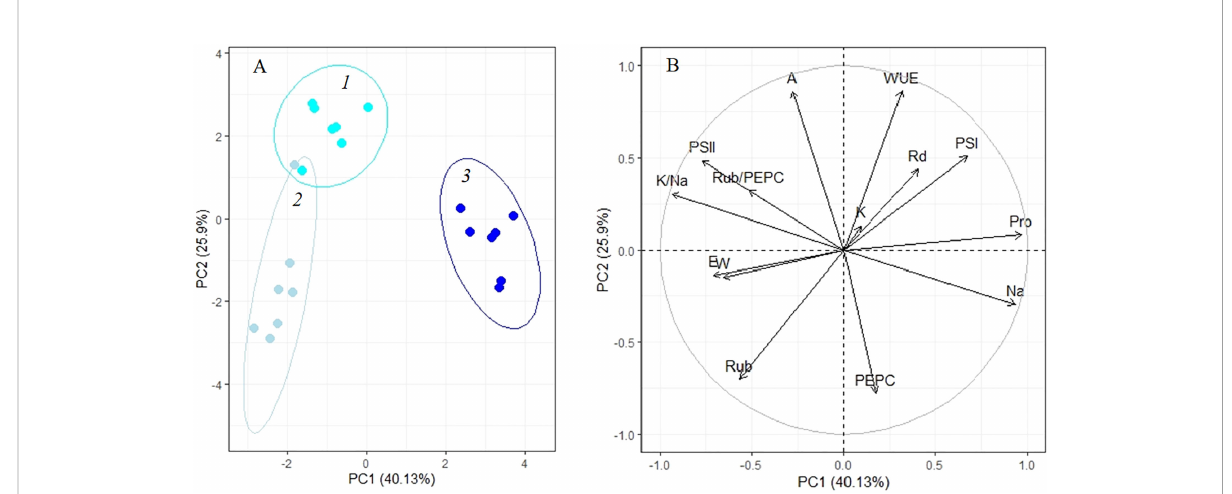
TABLE 1 Factor loading of morphophysiological and biochemical parameters on the main components (PC1 and PC2) of principal component analysis of C